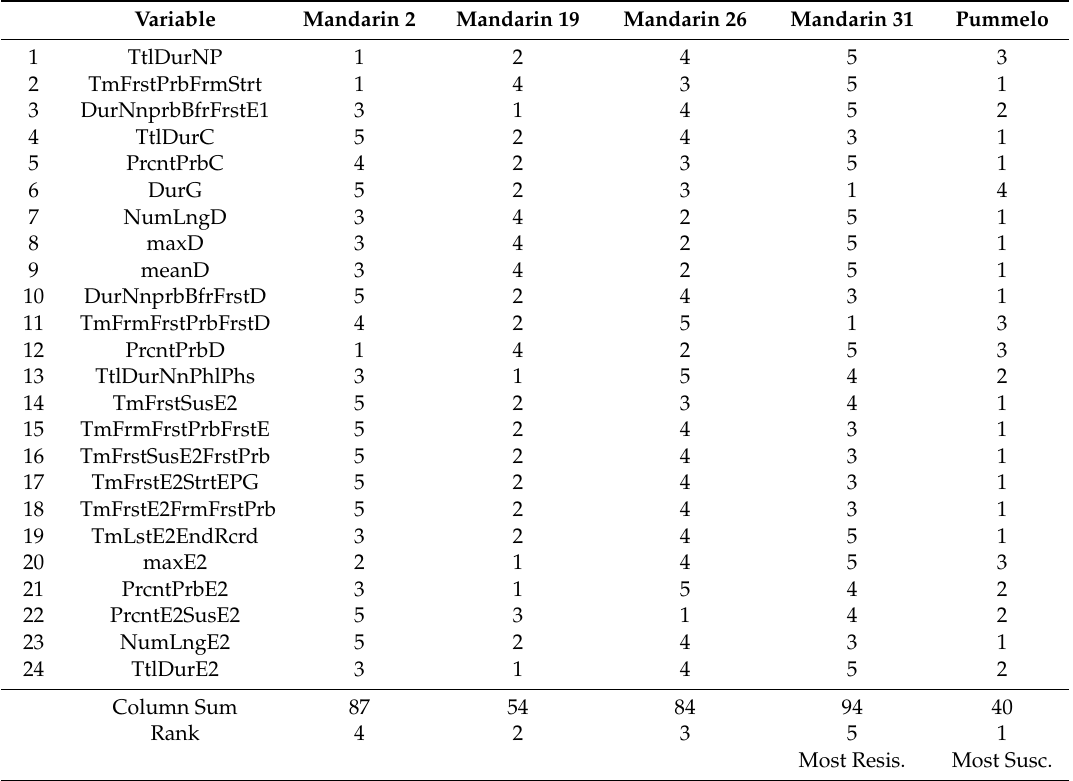
Table 2. Continuous ranks of probing variables of Diaphorina citri probing four Mandarin selections and Pummelo.